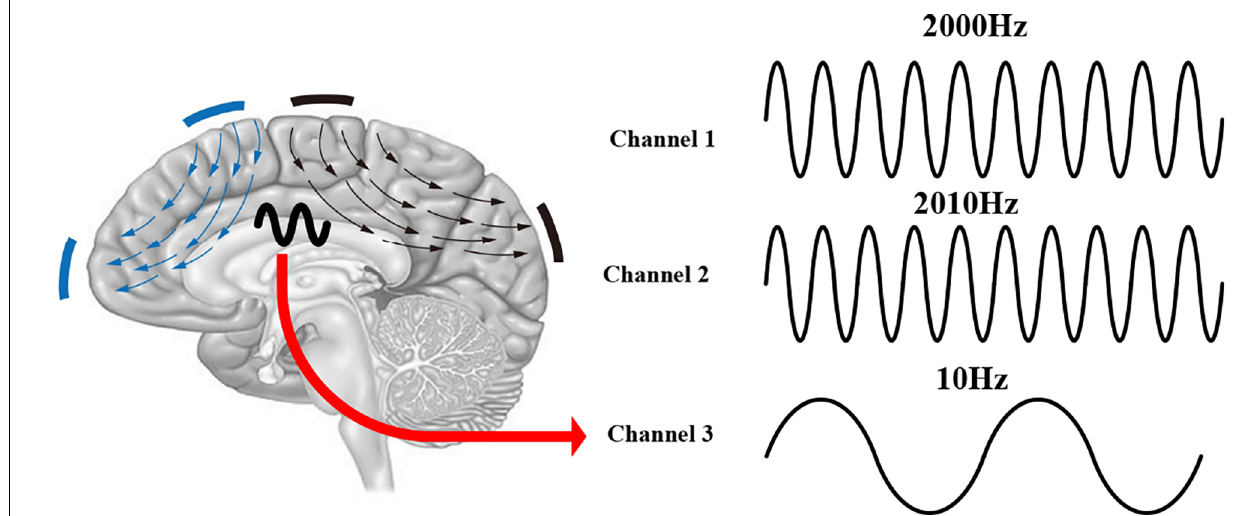
FIGURE 5 | Schematic diagram of temporally interfering (TI)